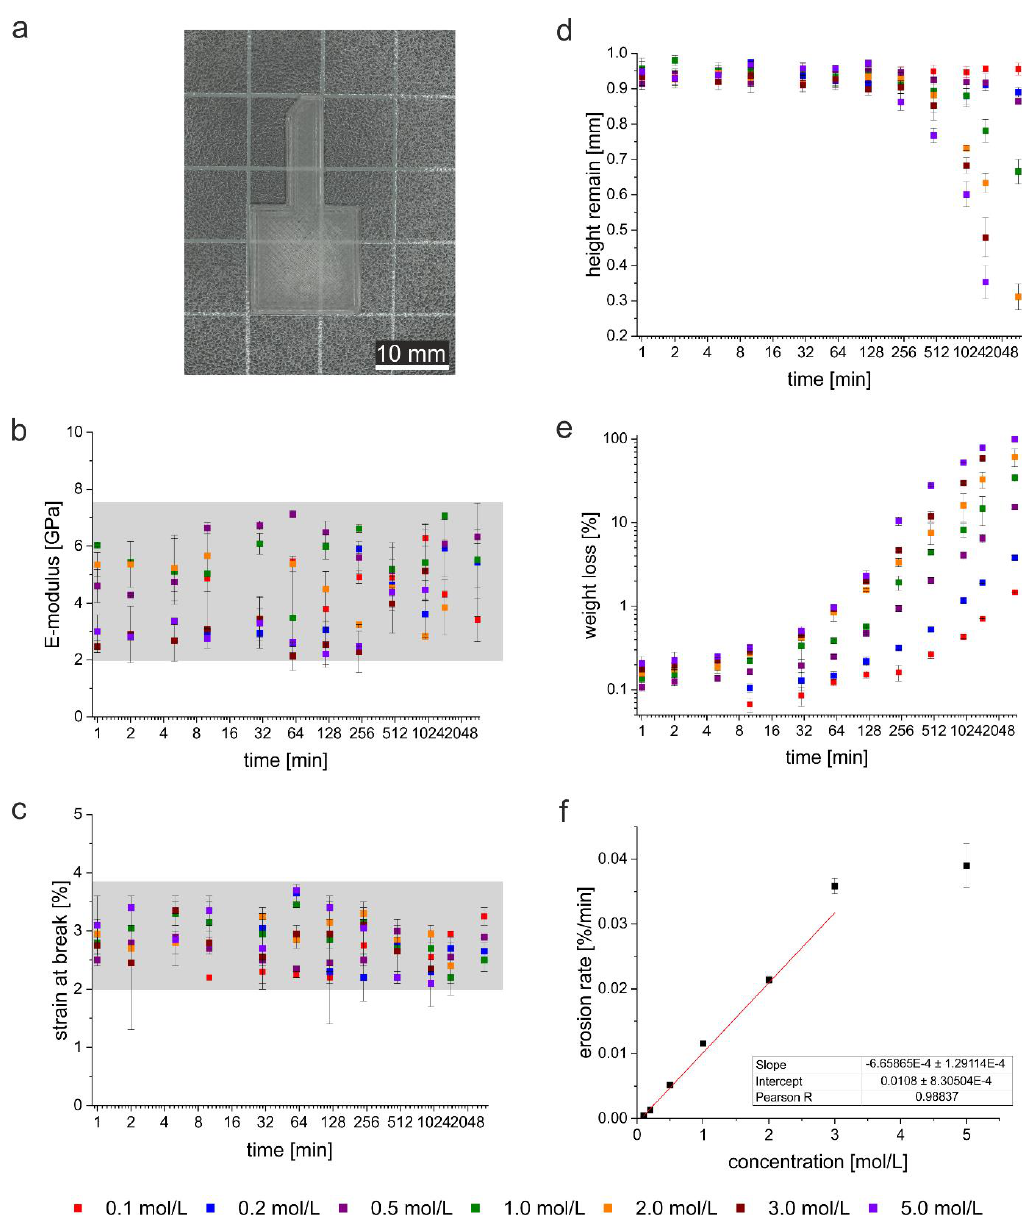
Figure 1. ( a ) Photograph of a typical sample used, ( b ) elastic modulus, ( c ) strain at break vs. exposure time and NaOH concentration, ( d ) remain height, ( e ) weight loss, ( f ) rate of erosion with linear regression. Grey areas indicate region where experimental E-moduli and strain at break have been measured. Note that for NaOH concentrations of 3.0 and 5.0 mol/L and exposure times of 1440 min or longer no data are available due to complete sample dissolution. As a result, for these materials and treatments, no data can be plotted.